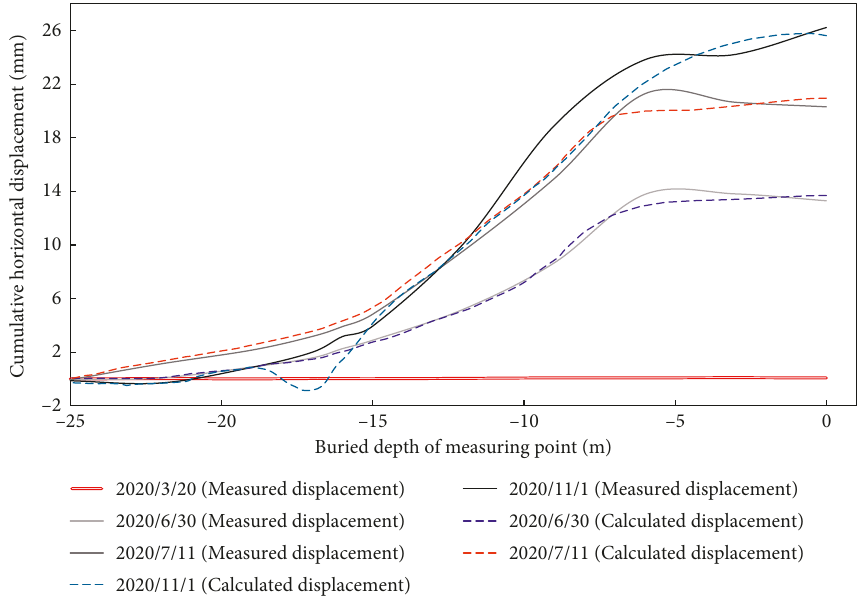
Figure 10: Cofferdam slope soil horizontal displacement fitting curve.